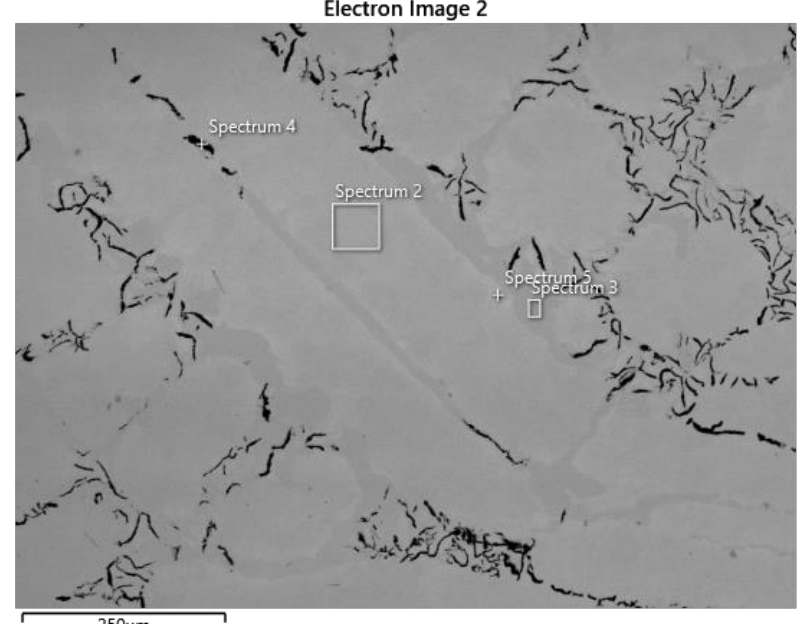
Figure 5. Optical microscope microstructure of metallic material obtained after CC02 dilatometer test (Nital 2%). Appl. Sci. 2020 , 10 , x FOR PEER REVIEW 8 of 14